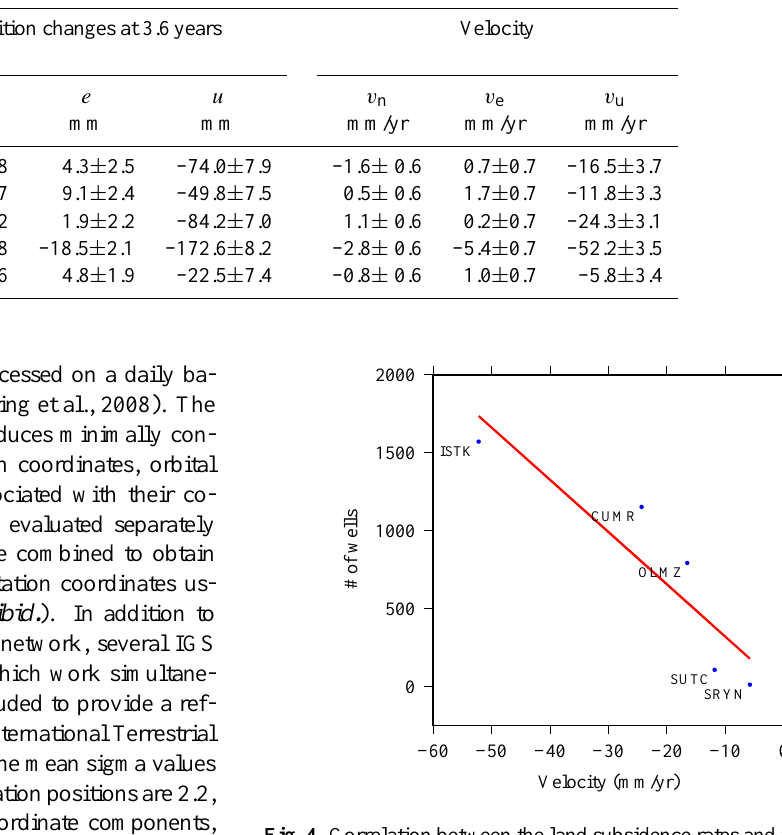
Table 1. Comparison the heights from precise leveling in different time periods, 1973–1984 and 2005 (Anony- mous, 2005)